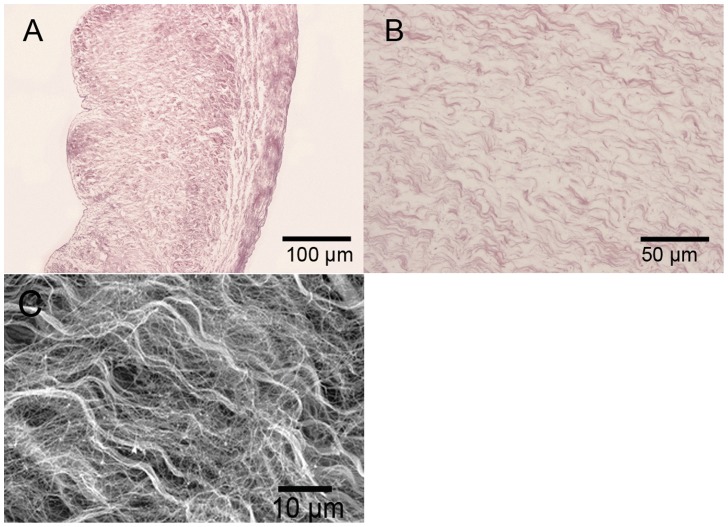
Histology of DPAV were analyzed with H&E and SEM.H&E photomicrographs (A, B) and SEM (C) of decellularized porcine aortic valve, all showing that the cellular components of the porcine aortic heart valve leaflets were completely removed. The wave-like collagen fiber was conserved. (A) Scale bars: 100 µm; (B) scale bar: 50 µm; (C) scale bar: 10 µm.